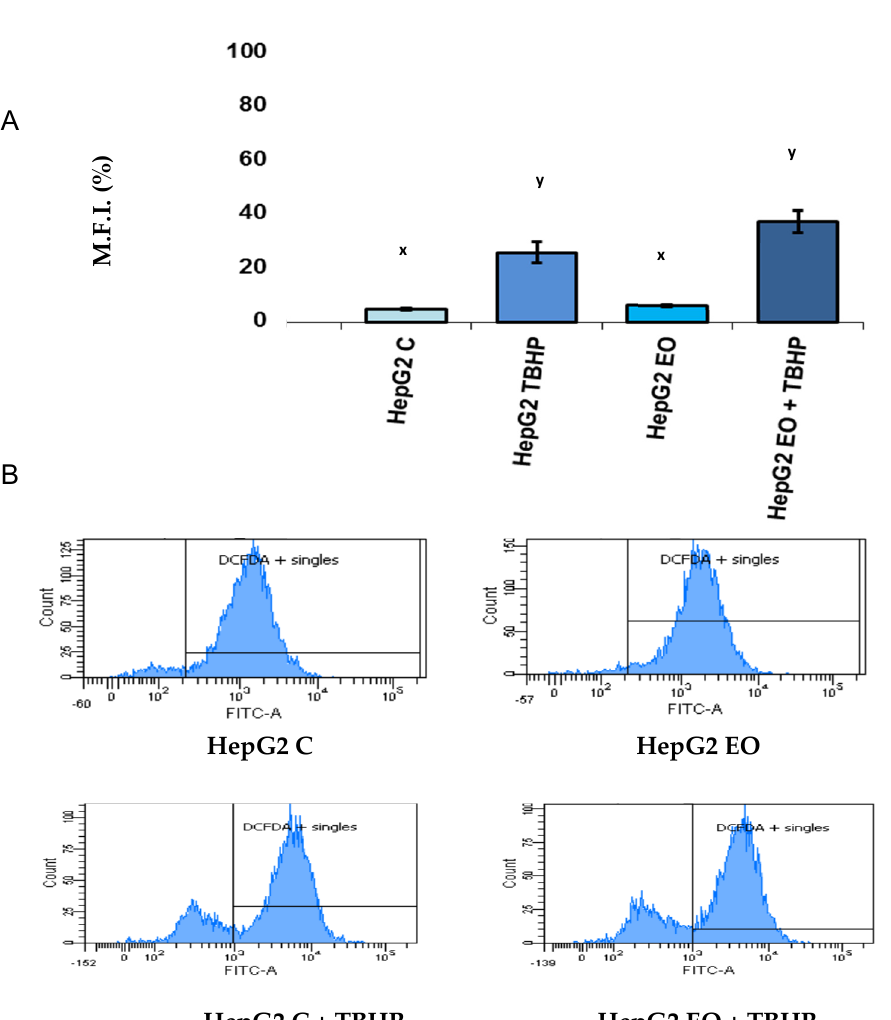
Figure 2. Effect of 24 h incubation with erythrodiol at IC 50 concentration on the reactive oxygen species (ROS) levels in HepG2 cells. Dichlorofluorescein (DCFC) and tert-butyl hydroperoxide (TBHP) were used. ( A ) Results of the mean fluorescence intensity are expressed in percentage (%). ( B ) The number of DCFC-positive cells and the quantity of emitted fluorescence are shown. Different letters (x or y) indicate different significance levels. Table 1. Effects of erythrodiol (EO) on the specific activity at saturated substrate concentrations of